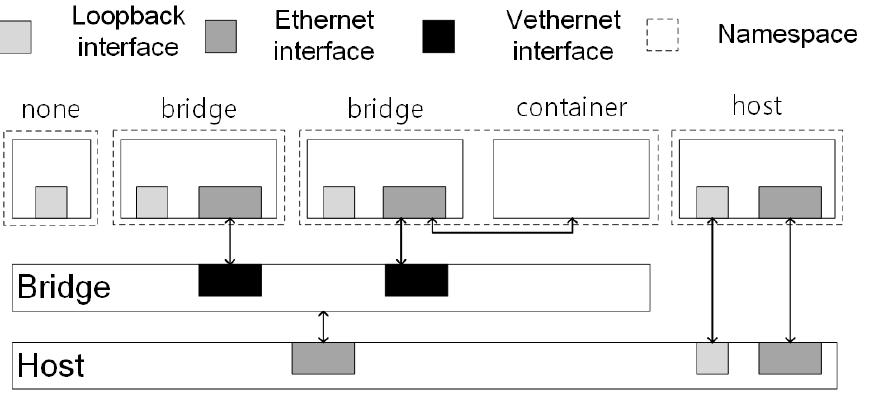
Figure 4. Single-host networking